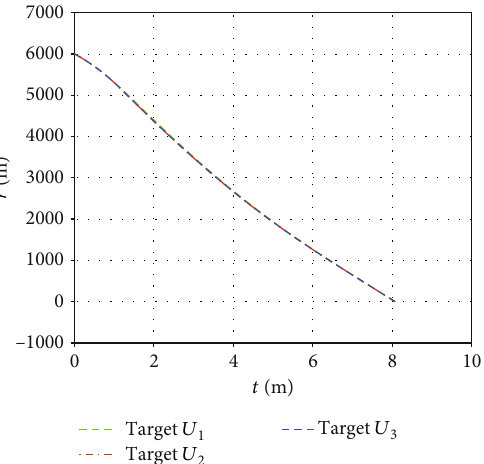
Figure 21: Relative trajectories.